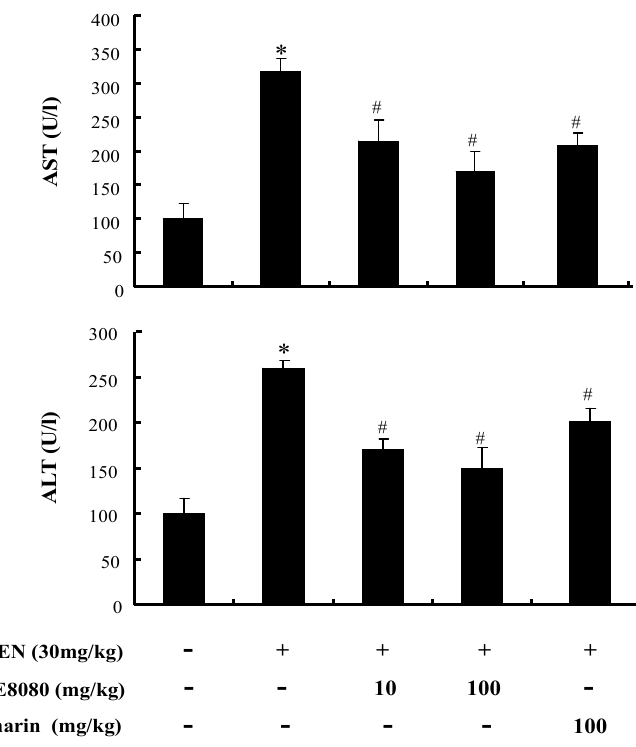
Figure 6. Effects of ginger extracts administration on the activities of serum aspartate aminotransferase and alanine aminotransferase in DEN-treated mice. Each value represents the mean ± S.D for 5 mice. * p < 0.05, significantly different from the unstimulated control group. # p < 0.05, significant differences from the DEN-treated